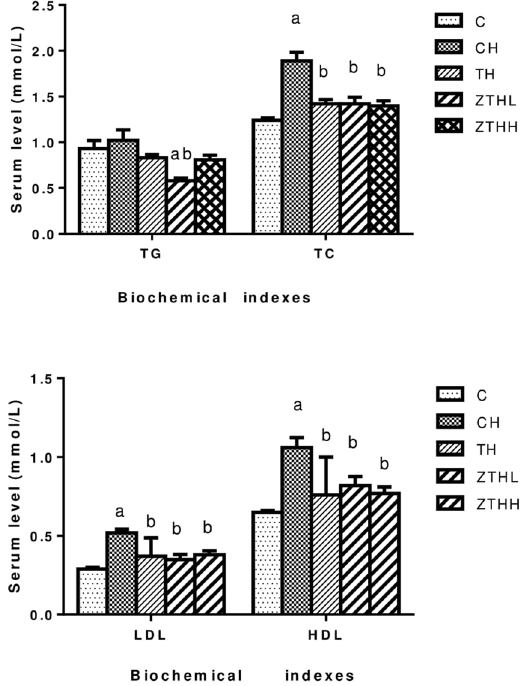
Figure 7. Effect of zinc selenium tea on serum TC, TG, HDL-C, and LDL-C concentrations (n = 10, mean and SEM) in experimental groups. a Vs C-group, p < 0.05; b vs CH-group, p < 0.05.